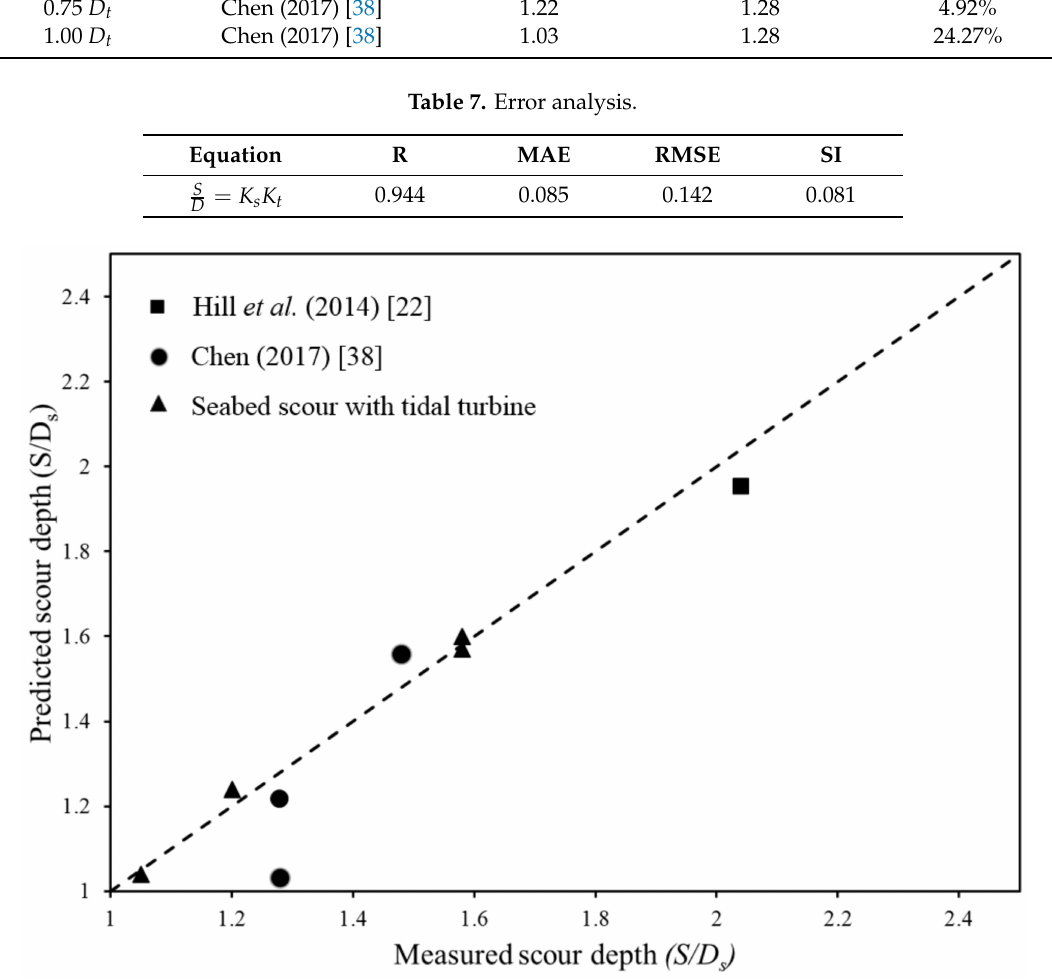
Figure 17. Scattered plot of measured and predicted seabed scour